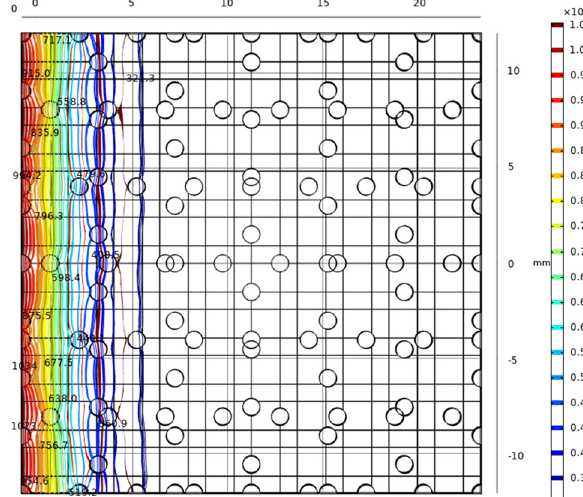
Figure 5: Simulation results for horizontal heat conduction.